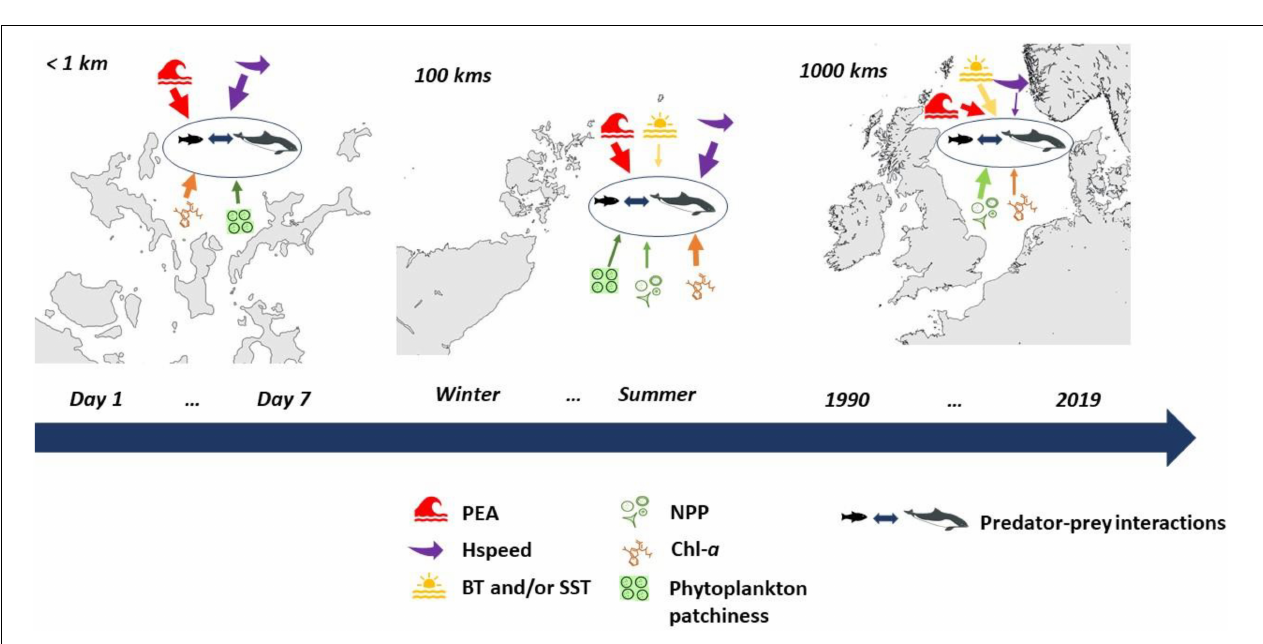
FIGURE 7 | Illustration of the variability of biophysical relationships (represented by the arrows) across spatial and temporal scales. Note, the width of the arrows represents the relevant “importance” of the indicator on the relationship at each scale, which was determined based on all the reviewed literature for this